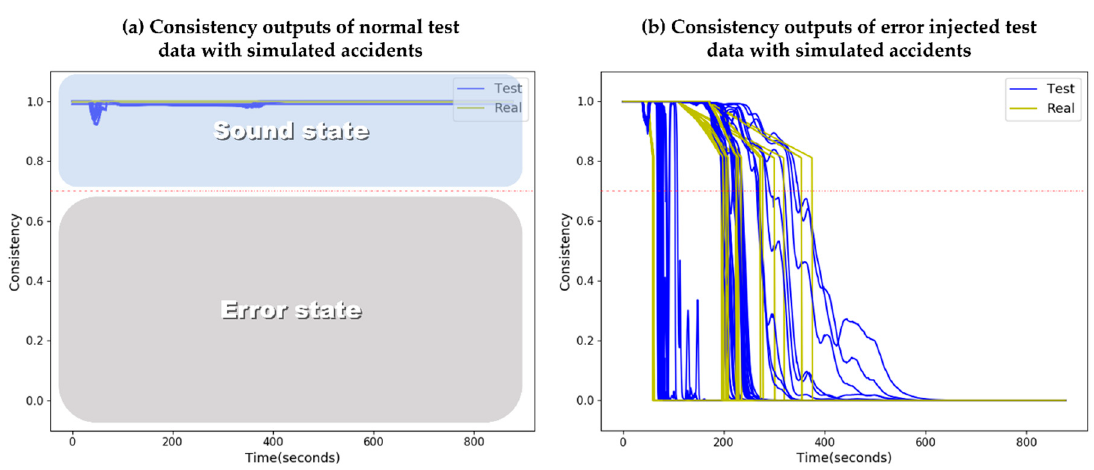
Figure 4. Examples of sensor state identification with ( a ) normal data test results and ( b ) error injected data test results. This figure is adapted from [13].